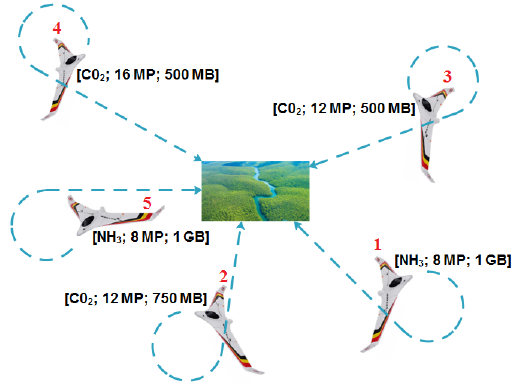
Figure 1. Visual sensing and pollution monitoring